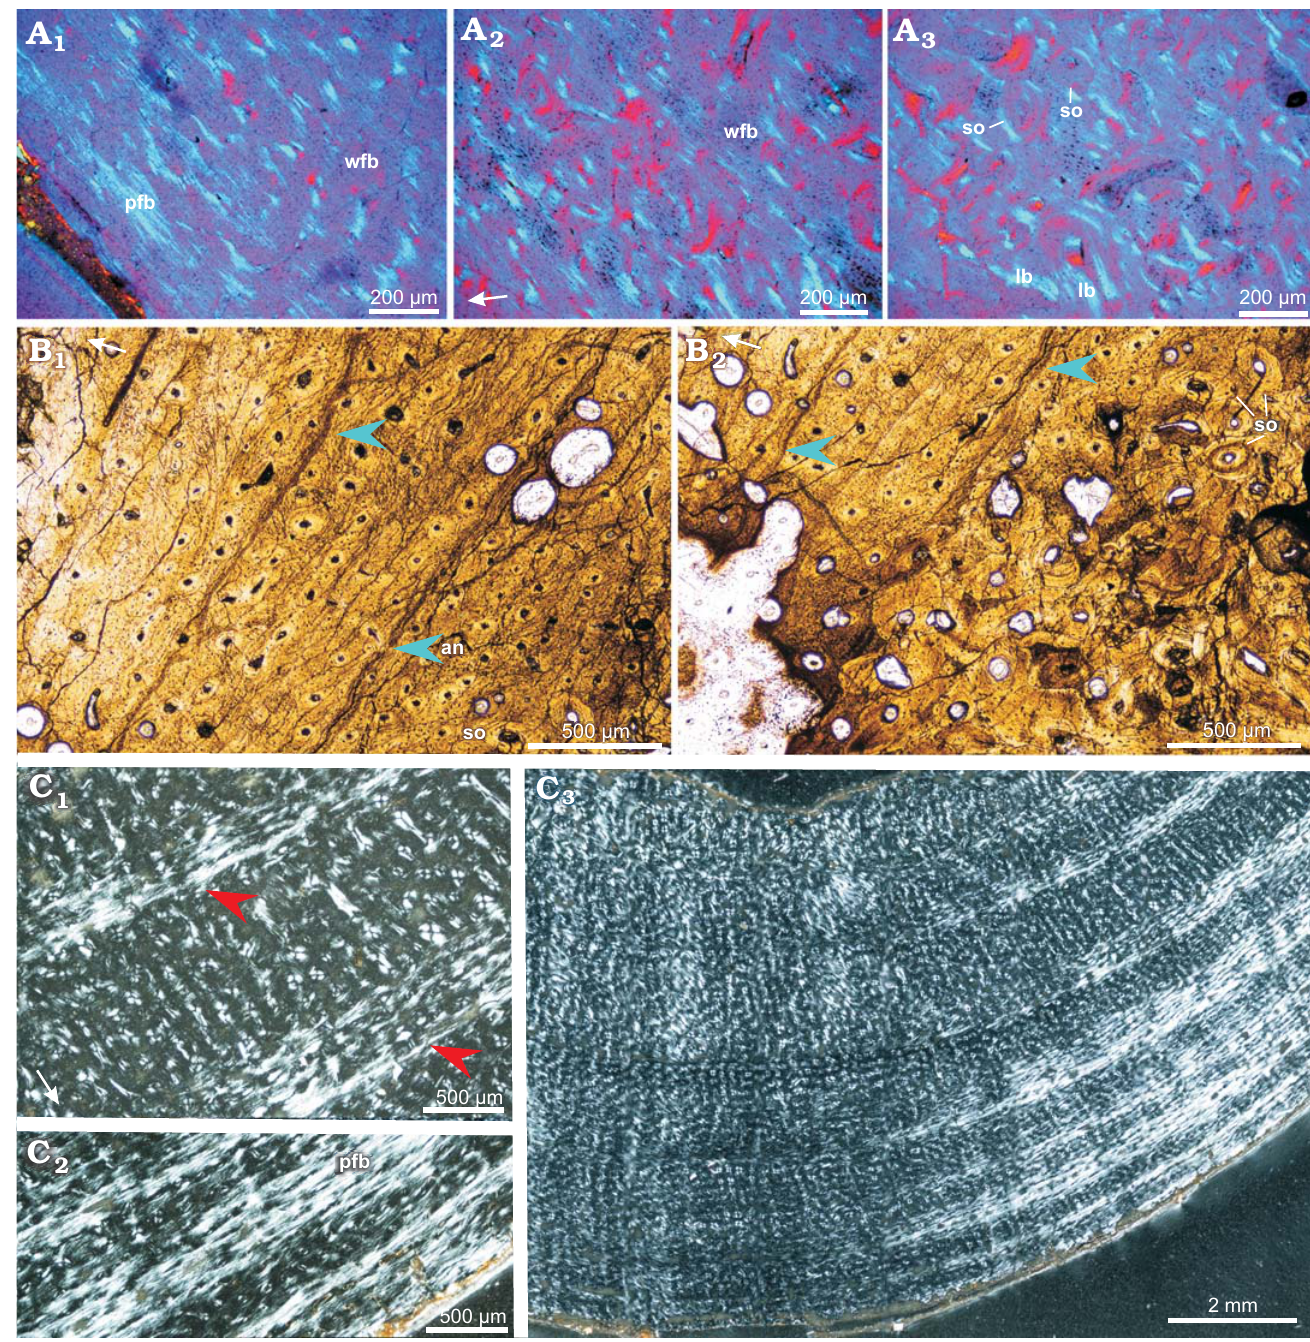
Fig. 9. Bone microstructure in adult Protoceratops andrewsi Granger and Gregory, 1923, Bayn Dzak, Mongolia, Late Cretaceous. A . Ulna ZPAL MgD-II/8, matrix in the outer (A 1 ) and mid-cortex (A 2 ), perimedullar region with endosteally-formed lamellar bone (A 3 ). B . Fibula ZPAL MgD-II/11b; note well formed LAGs (blue arrowheads) and annulus in the cortex (B 1 ); deeper cortex shows signs of remodeling and multiple secondary osteons (B 2 ). C . Femur ZPAL MgD-II/11a, compacta showing wider zones of fast growing woven-fibered bone intersected by thin annuli of parallel-fibered bone (red arrowheads) in the mid-cortex (C 1 , C 3 ); condensation of the parallel-fibered bone zones in the outer cortex (C 2 ). A, polarized light (quartz wedge); B, normal light; C, polarized light. White arrows point outward. Abbreviations: an, annulus; lb, lamellar bone; pfb, parallel-fibered bone; so, secondary osteons; wfb,